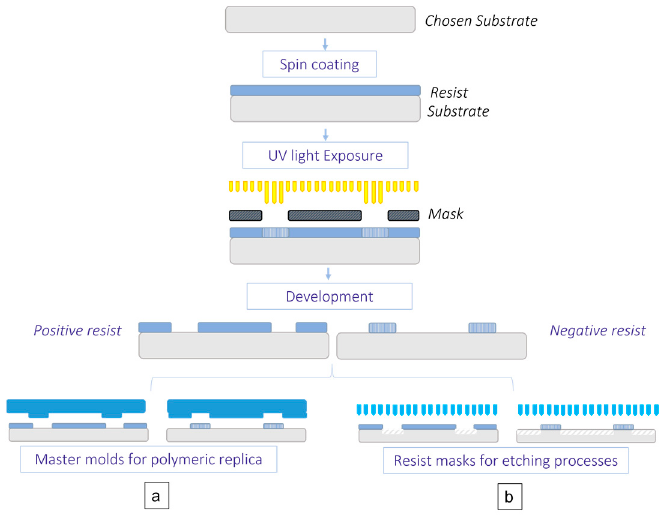
Figure 6. Scheme of the photolithographic approach. The photoresist is spin-coated on the chosen substrate and exposed to UV light with the interposition of a patterned mask. Positive photoresists degrade when exposed to radiation, and negative photoresists cure. The final structure can be either directly used as a master mold (soft lithography) ( a ) or serve as a mask for further processes (etching) ( b ).